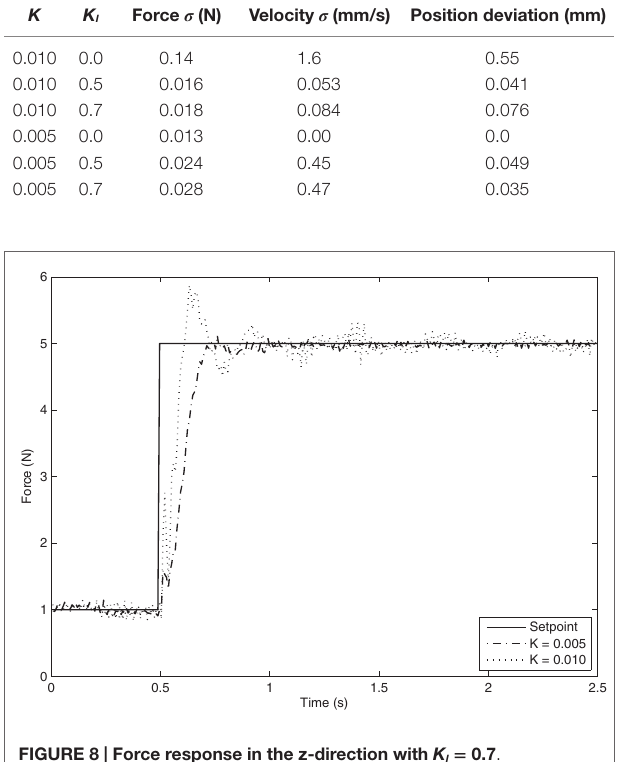
FigUre 8 | Force response in the z-direction with K I = 0.7